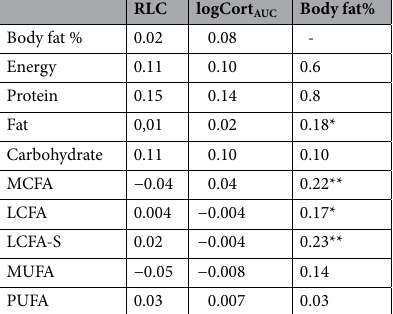
Table 4. Correlation between maternal body fat, dietary intake of nutritional components, maternal stress (RLC), and cortisol level (Cort AUC ). *p < 0.05. **p <